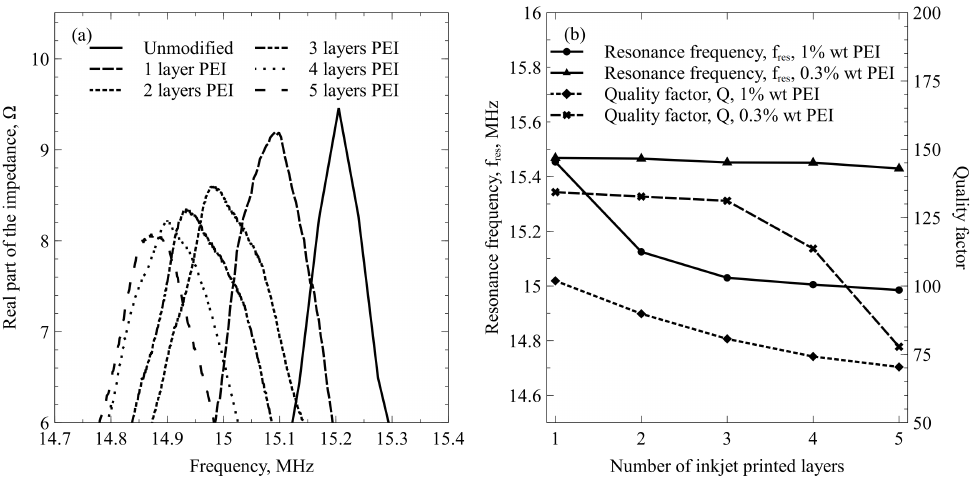
Figure 8. Functionalization shift in ambient air: ( a ) the frequency spectra of the real part of the CMUT electromechanical impedance before and after functionalization with an increasing number of inkjet-printed PEI layers of 1.0% w / v concentration; ( b ) resonance frequencies and quality factors of the sensors as a function of different numbers of inkjet-printed PEI